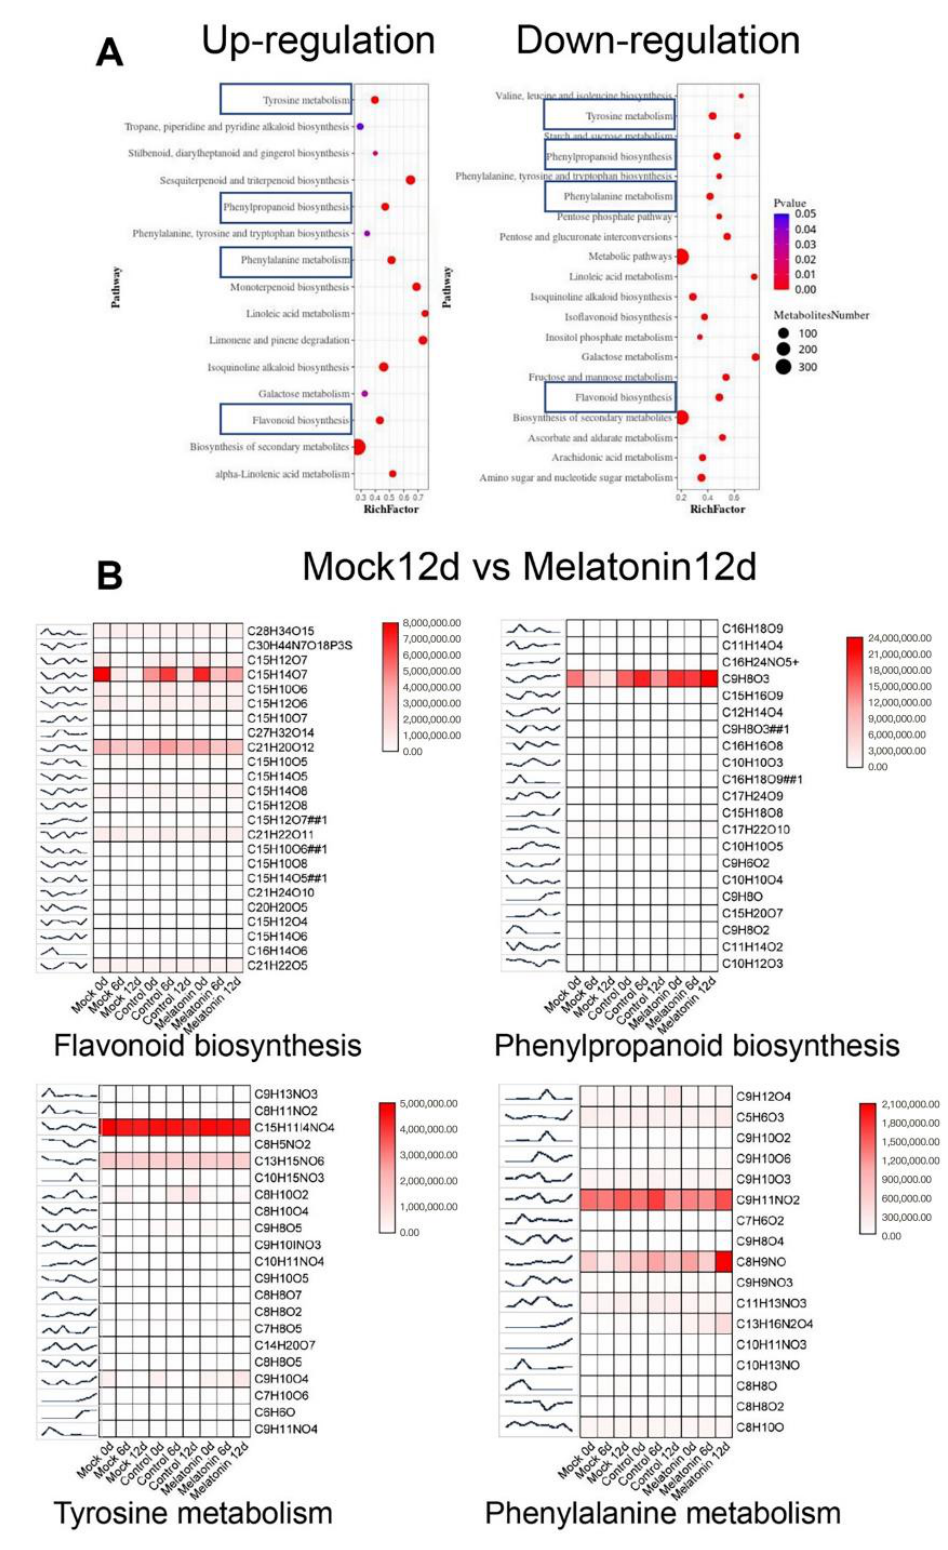
Figure 6. Metabolomics changes of the fresh-cut lotus roots treated with exogenous melatonin. KEEG pathway enrichment of compounds in different treatments after treatment for 12 days ( A ). Differential ion cluster analysis of compounds enriched in selected pathway ( B ).